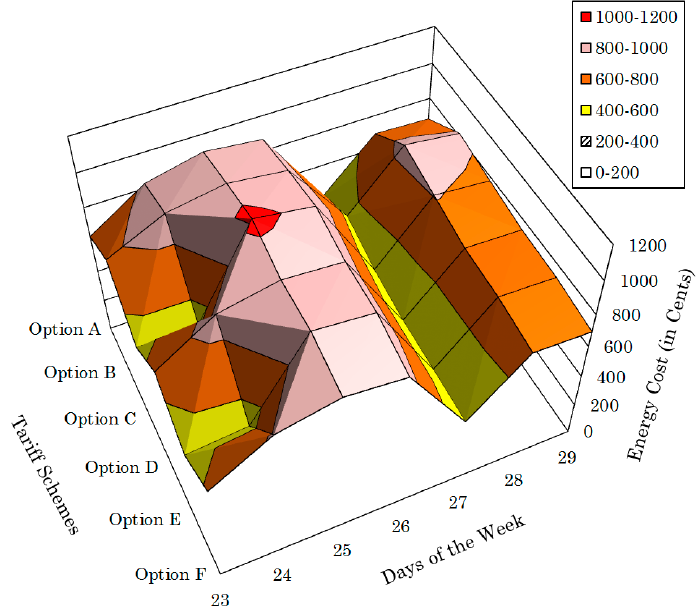
Figure 13. The consumed energy cost in cents by the PID of the controlled AC unit by employing the 6 options of ToU rates.